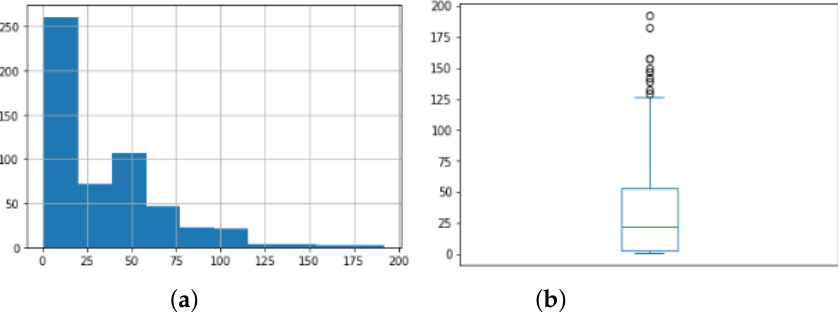
Figure 9. ( a ) Histogram for number of events. ( b ) Box plot for number of